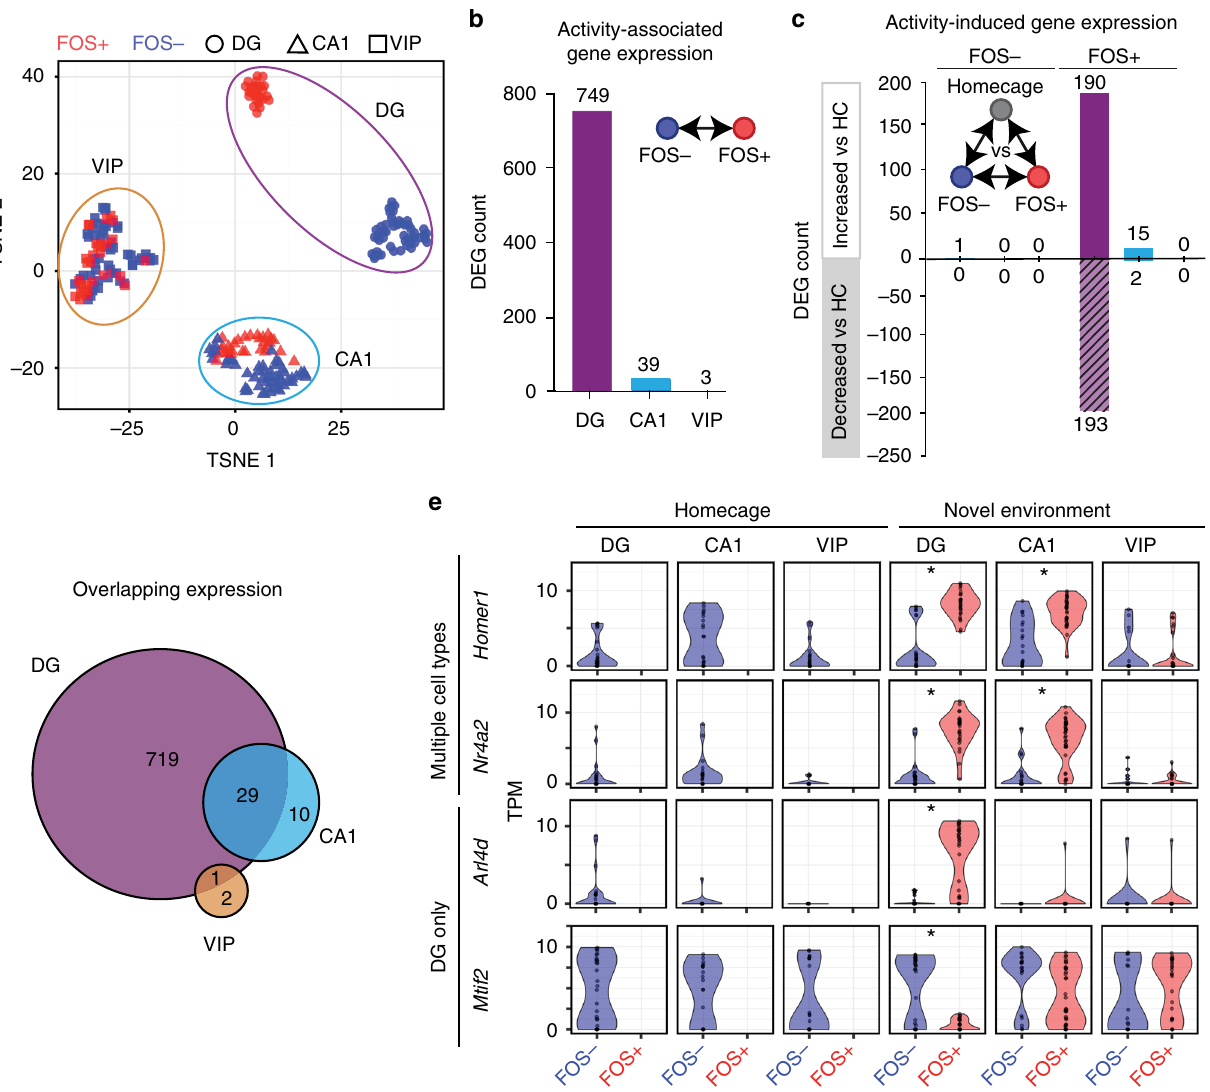
Fig. 2 Activity-induced gene expression across the hippocampus. a T-SNE plot of DG, CA1, and VIP nuclei stained for FOS and isolated from mice exposed to a NE. b DEG count between FOS + and FOS − nuclei for each population in A. c DEG count after correcting for HC expression. Bars extending upward and downward represent genes that are increasing or decreasing in the given cell type compared to HC, respectively. d Overlap of DEGs across cell types. e Representative violin plots of DEGs. Each dot represents a single nucleus. * ROTS p adj